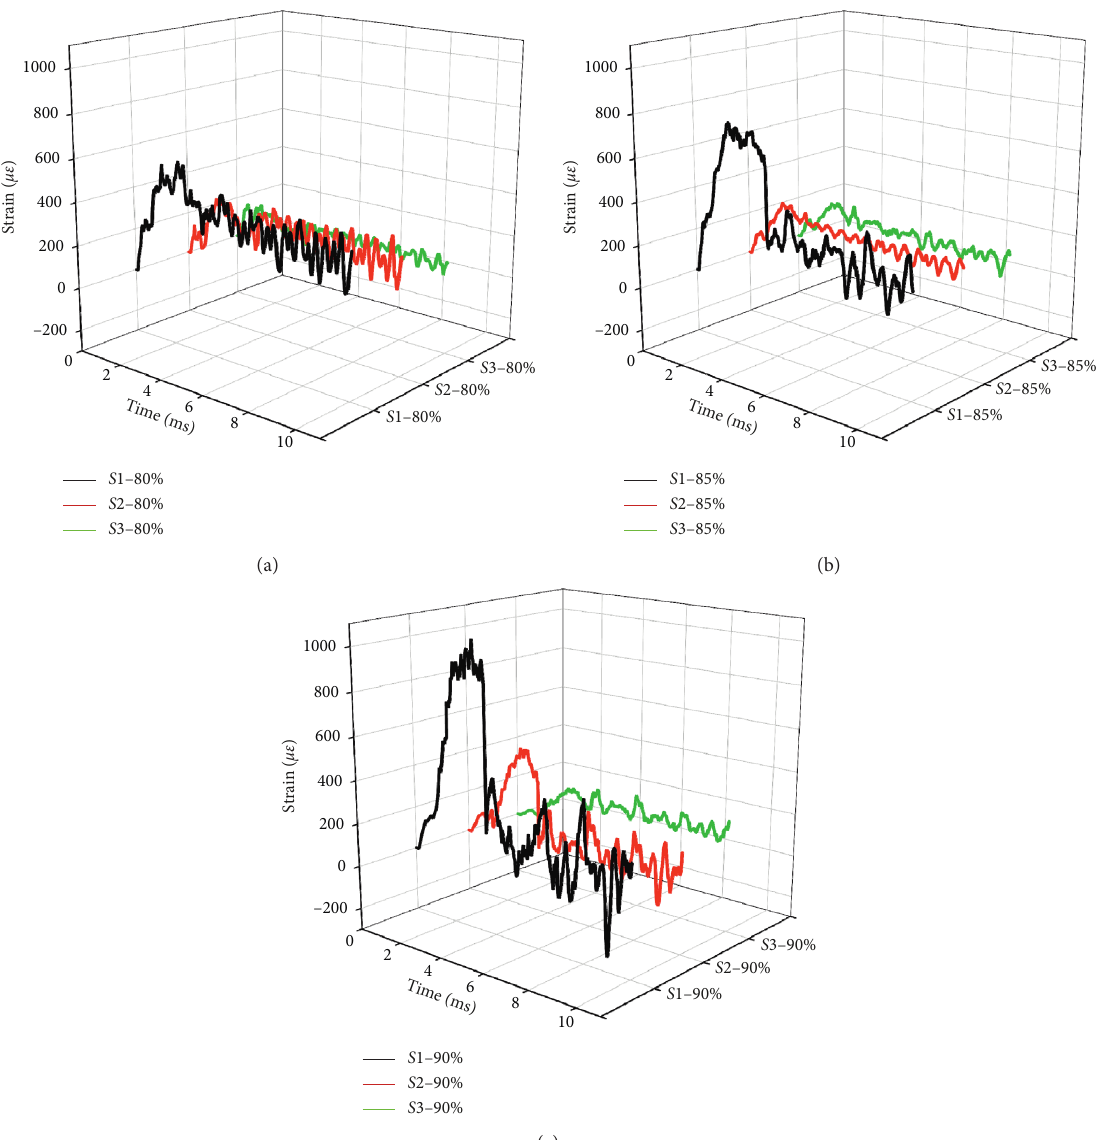
Figure 8: Strain time-history curve of each measuring point under different porosity under simulation. (a) 80%. (b) 85%. (c) Figure 9 is a comparison chart of the numerical simu- lation results and test results of the peak strain values of the three groups of porosity aluminum foam under the explosive shock wave of the charge. In order to quantitatively describe the difference between the test and the numerical simulation, the numerical simulation results of the strain at each measuring point of the bottom plate are taken as the x -axis, and the test results are taken as the y -axis, and Figure 9 is drawn. The line with a slope of 1 in the figure indicates that the numerical simulation results are completely consistent with the test results. When the test point falls below the straight line, it means that the measured strain given by the numerical simulation is greater than the test value; when the test point falls above the straight line, it indicates that the peak value of strain at each measuring point calculated by